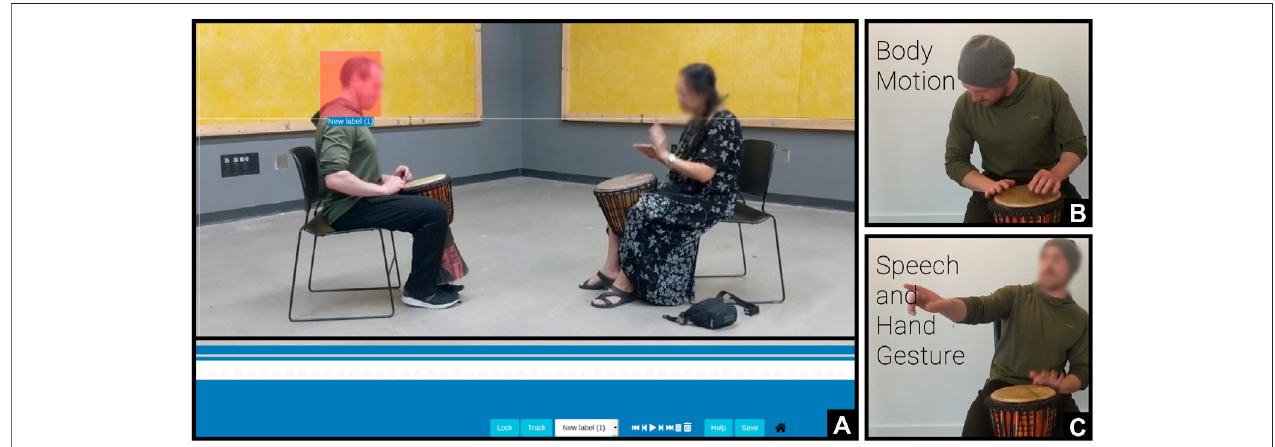
FIGURE2| Left (A) :Analysisoftwodjembedrummersduringanimprovisationsession.Eye-glances,facialexpressions,andotherbodymotionwererecordedand analyzed. Researchers placed a pink square and labeled it for “ looking at his drum head ” among other communication modalities (e.g., looking at the other drummer ’ s face, or hands, or drum heads, etc.) Right (B) and (C) : We captured motion from a live drummer using IR-based motion capture. The motion data was converted into animations that control the avatars. Written informed consent was obtained from the individuals for the publication of any potentially identi fi able images or data included in this article.